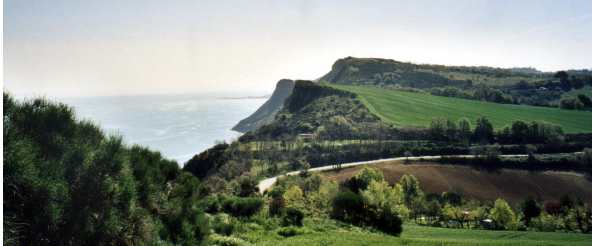
Figure 2. Panoramic view of Mount San Bartolo. The orientation of the cliff is NW–SE. In the background, towards the SE, is the harbour pier of Pesaro.